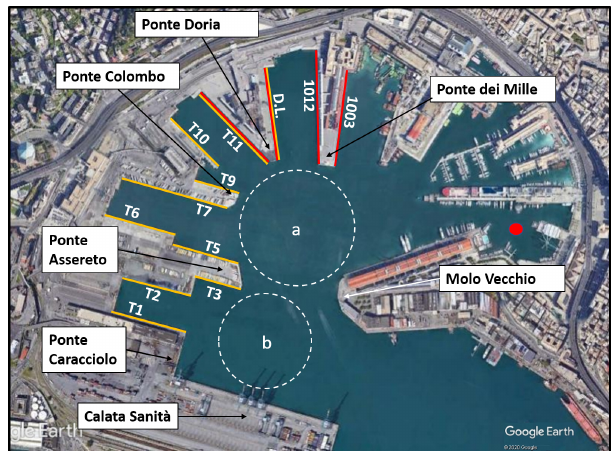
Figure 2. Passenger port of Genoa. The colored lines along the docks refer to the typology of the operating ships: red lines indi- cate cruise vessels, and orange lines indicate ferries. The names of the docks (in white) are given next to the colored lines. The red dot represents the location of the station where sediment samples with physical information on the grains are available (see Sect. 4.2). The white dashed circles “a” and “b” represent the turning areas for ves- sels berthing at docks T5–T11 and at T1–T3, respectively. Land background from © Google